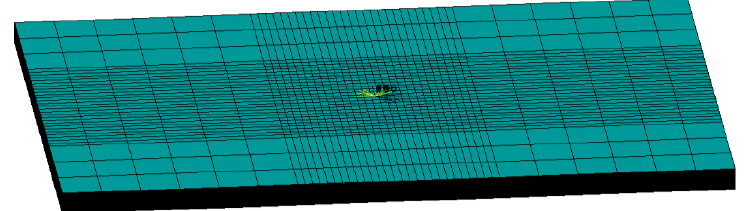
Figure 8. Finite element model of the stitched laminate.